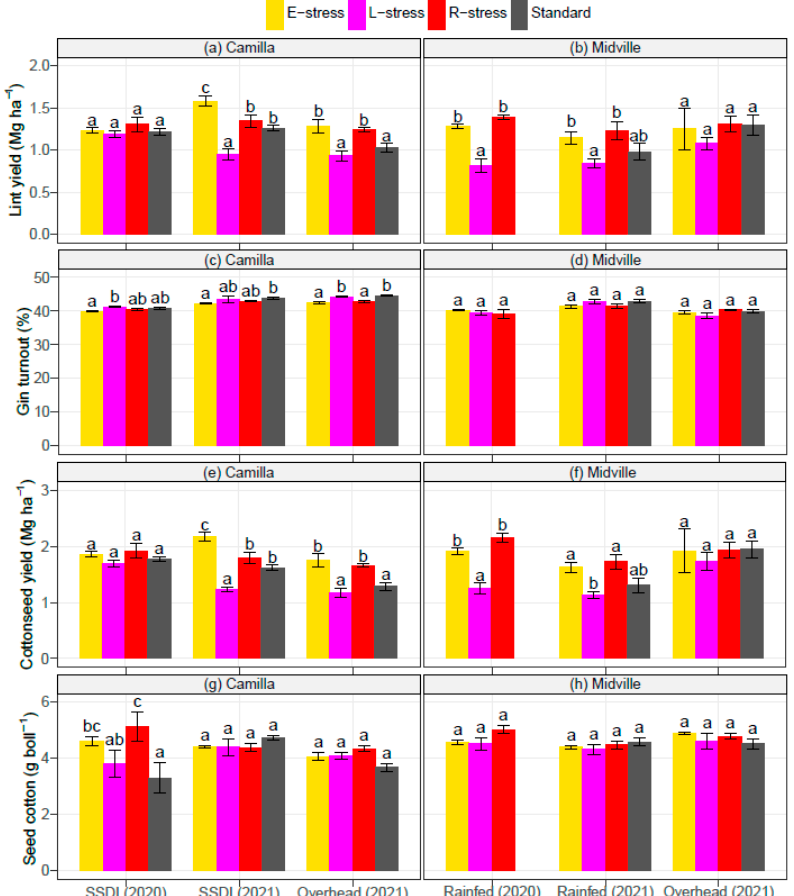
Figure 2. Nutrient stress effects on lint yield ( a , b ), gin turnout ( c , d ), cottonseed yield ( e , f ), and seed cotton yield per boll ( g , h ) in Camilla and Midville, GA under different production conditions. Within location and production conditions, means of nutrient stress treatments not sharing any letter are significantly different using the least squares means and adjusted Tukey multiple comparison procedure ( p < 0.05). Error bars indicate the standard error of the mean (n = 4). SSDI: Sub-surface drip irrigation.